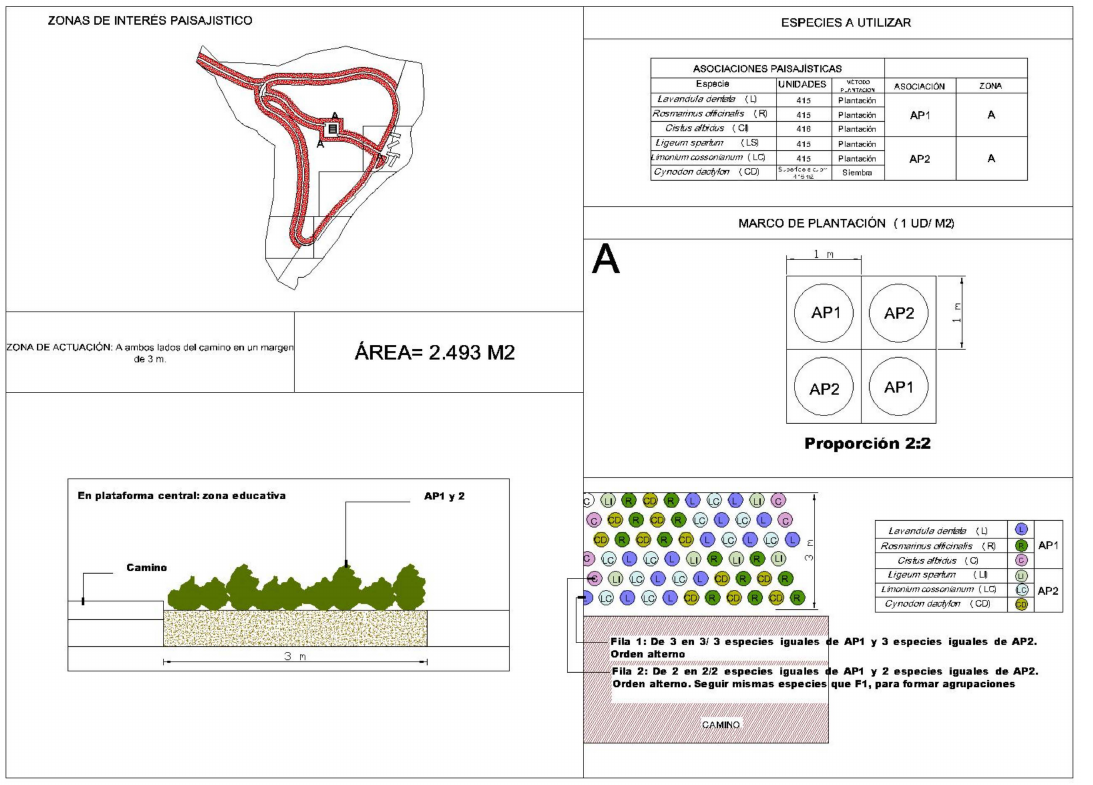
Figure A6. Planting map for zone A of Case Study 1.